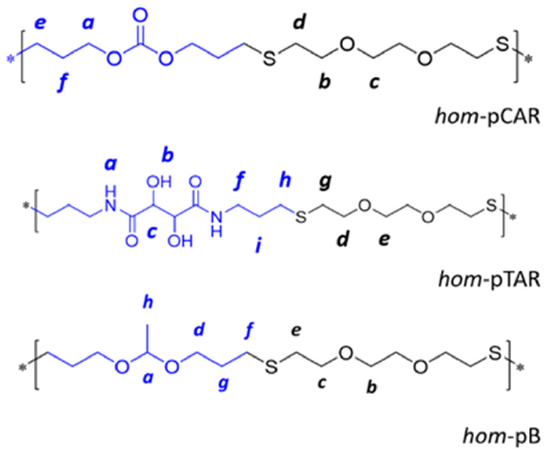
Figure 3. Schematic representation of constitutional repeating units for hom -pCAR, hom -pTAR, and hom -pB. In the case of the copolymers, the repeating units were those found in hom -pCAR and hom -pB in varied ratios, depending on the feed. Table 1. Preparation of homopolymers and copolymers.